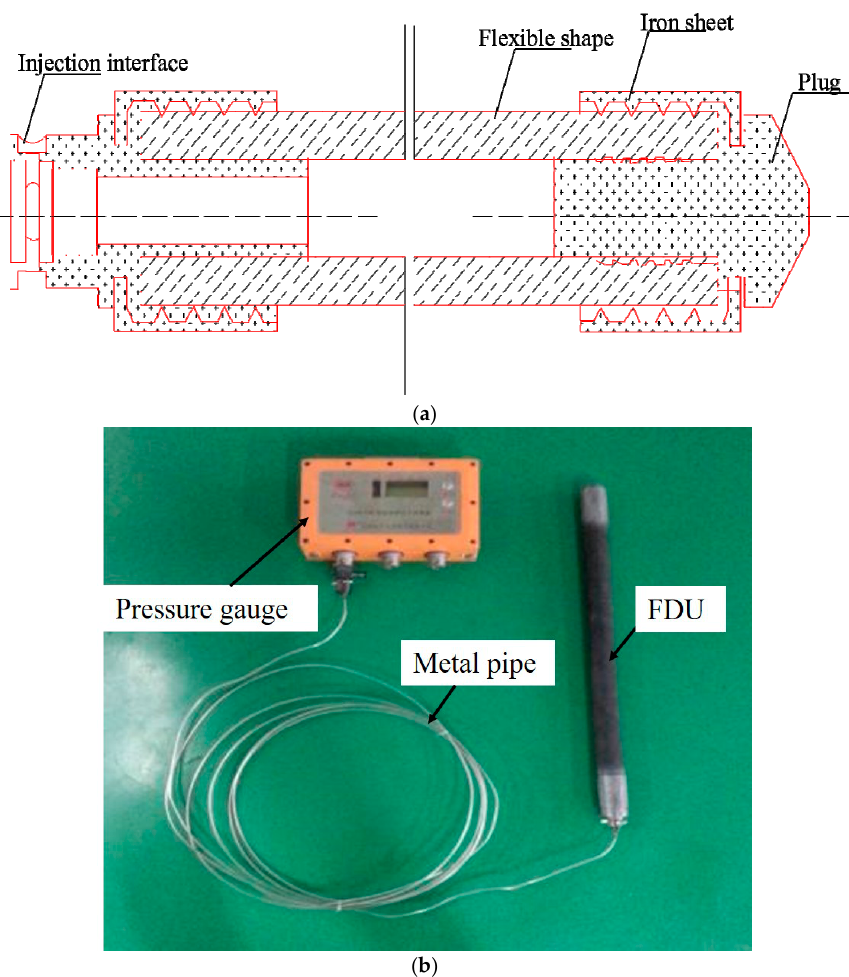
Figure 1. The picture of the flexible detection unit (FDU): ( a ) Interior structural diagram of the FDU. ( b ) Entity graph of the FDU.